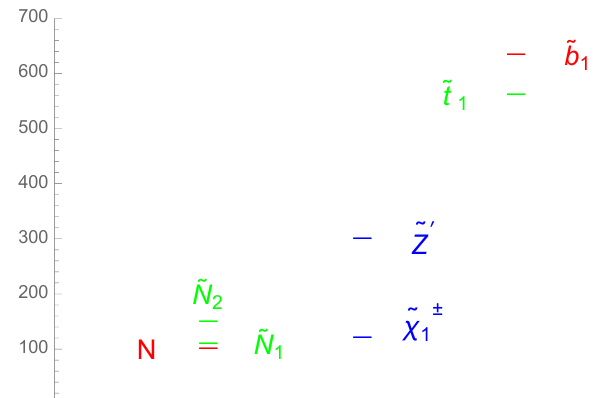
Figure 1. A typical mass spectrum for the cascade decay of ~ Z 0 via the mixing of left and right- handed